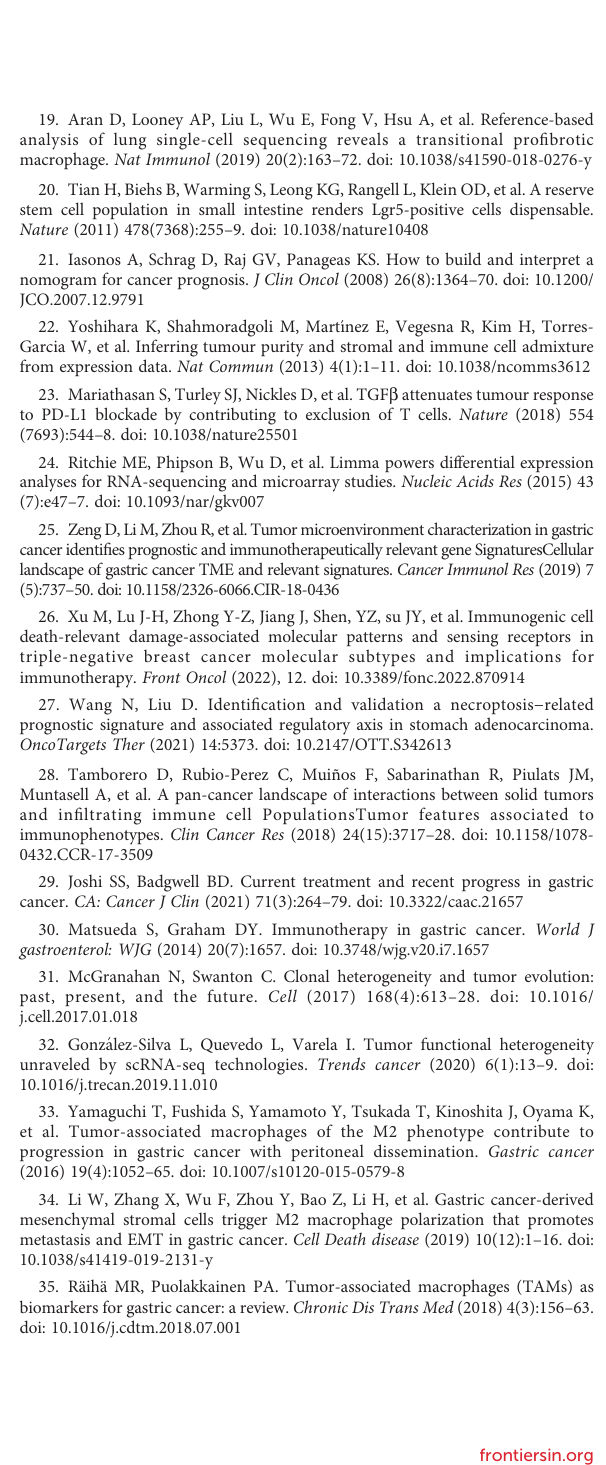
Spearman correlation analysis of model genes in the external validation cohort.